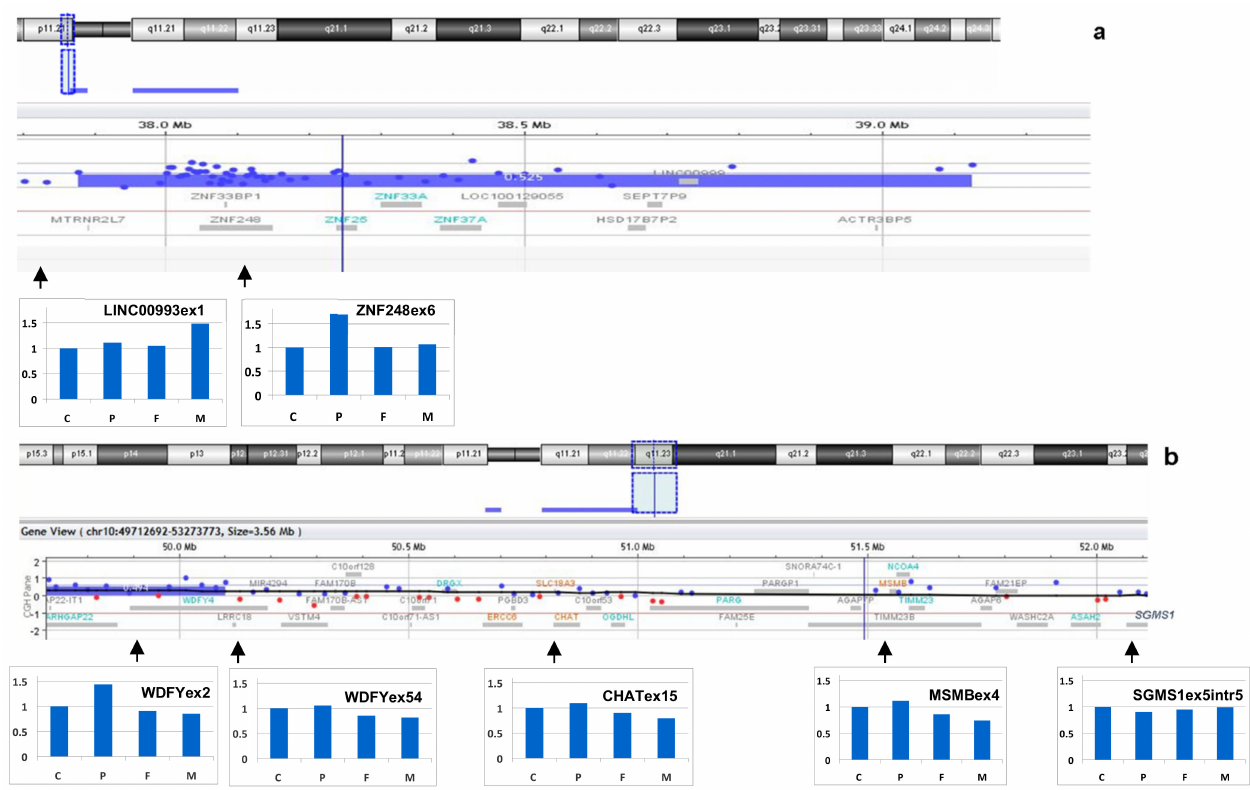
Figure 8. Quantitative real-time PCR analysis of the breakpoint boundaries and sSMC origin. ( a ) Confirmation of partial trisomy 10p11.21 and its boundary; ( b ) confirmation of partial trisomy 10q11 and its boundary. C—control, P—patient, F—father,